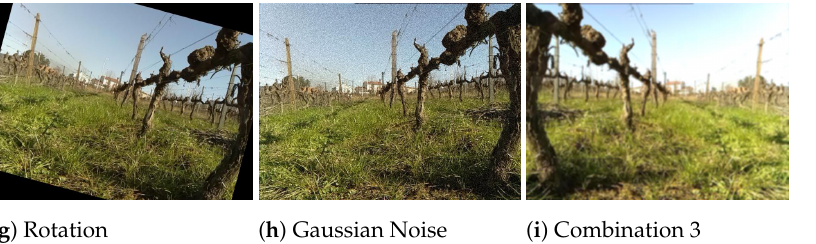
Figure 7. Set of several augmentation operations that were applied to VineSet, such as translation, multiplication, hue and saturation, flip, rotation, Gaussian noise, and, finally, a random combination of three of the previously mentioned